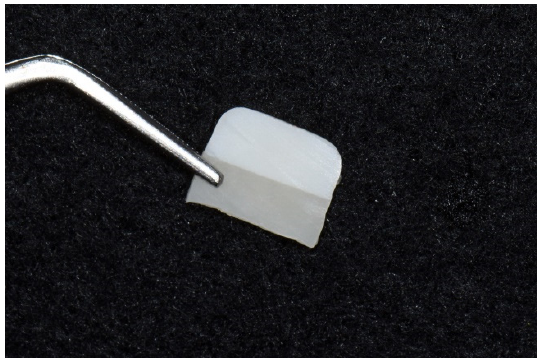
Figure 4. Sectioned ceramic–resin block (Top: LiSi Press, Bottom: Charmfil flow).